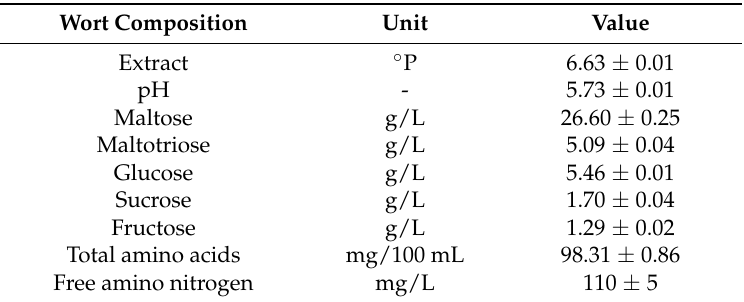
Table 3. Wort composition of fermentation wort.